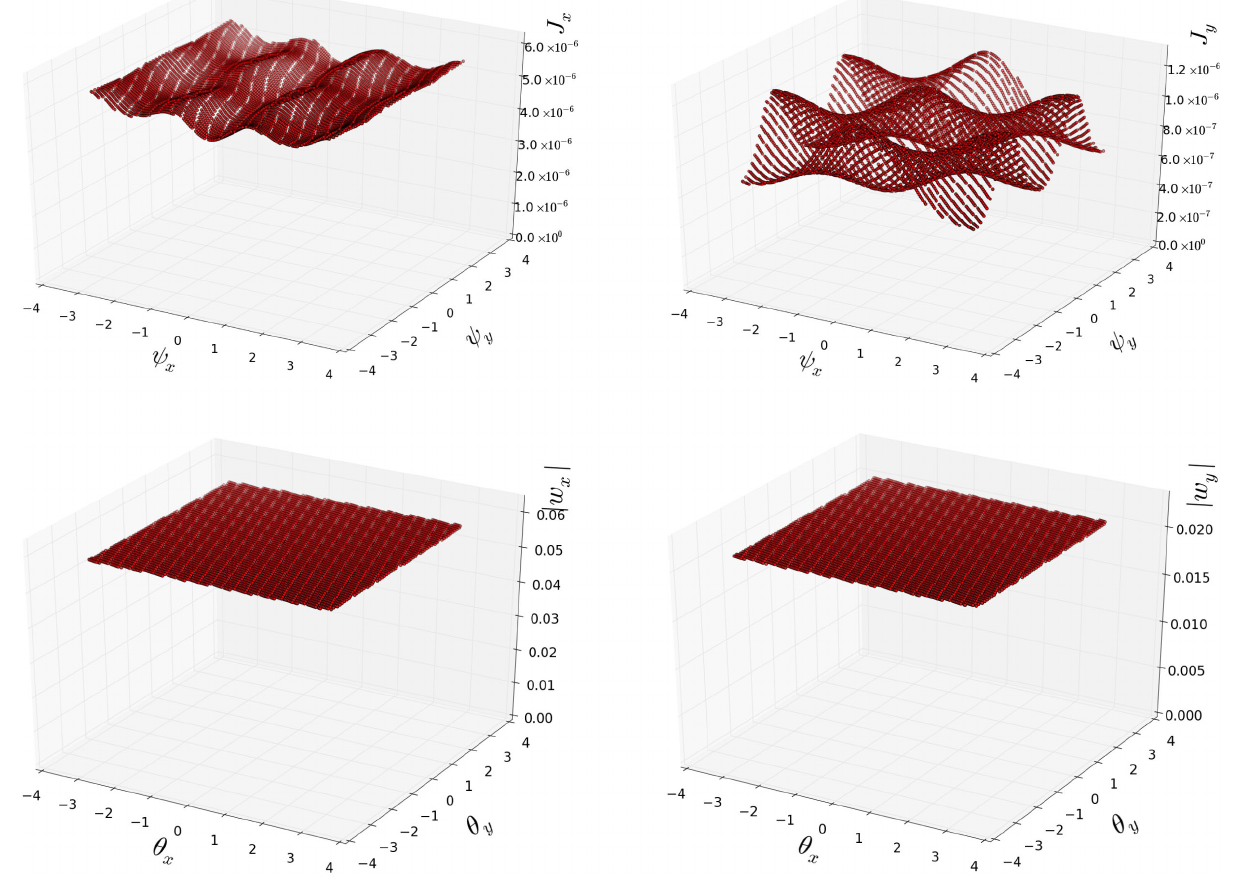
FIG. 8. Poincare surface of section using Courant-Snyder normalized variables ¯ z (bottom row). Left two plots are for x ; right are for y . Initial values of j w x ¼ 10 mm, y ¼ 2